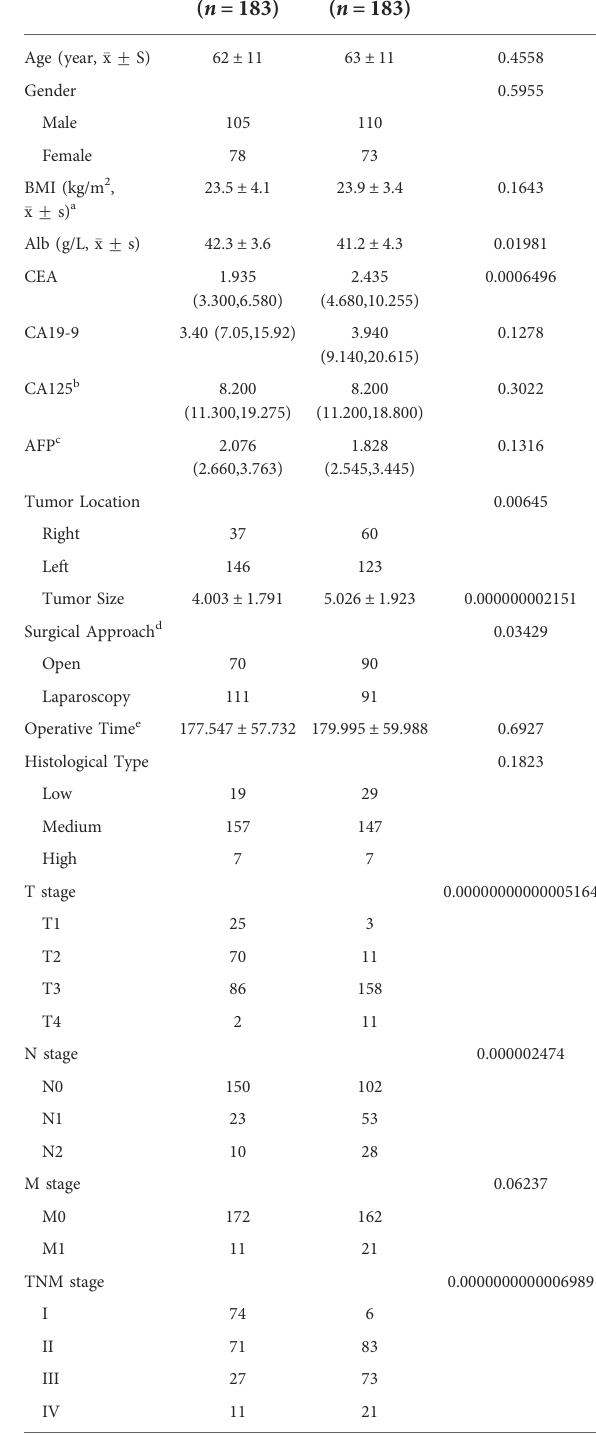
TABLE 2 Correlation between PIV and clinicopathological features in CRC